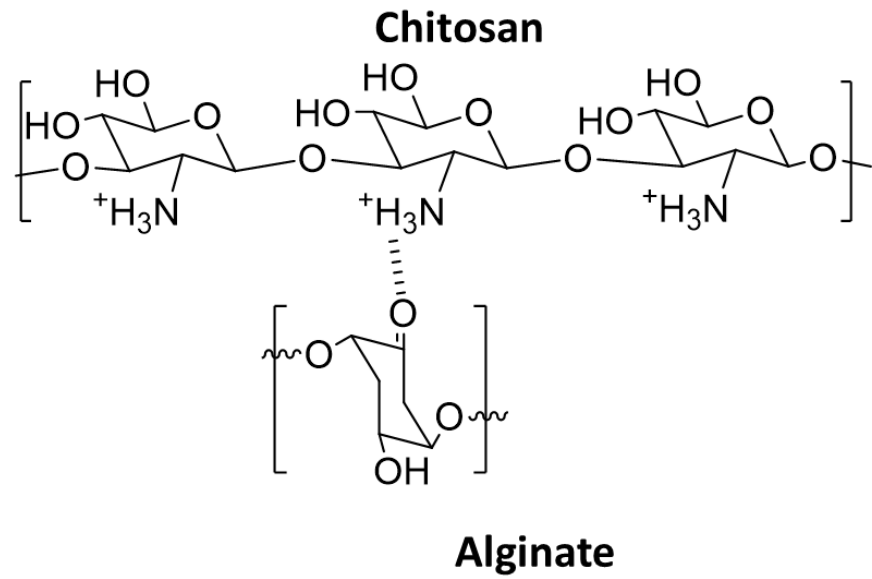
Figure 11. Chitosan-alginate